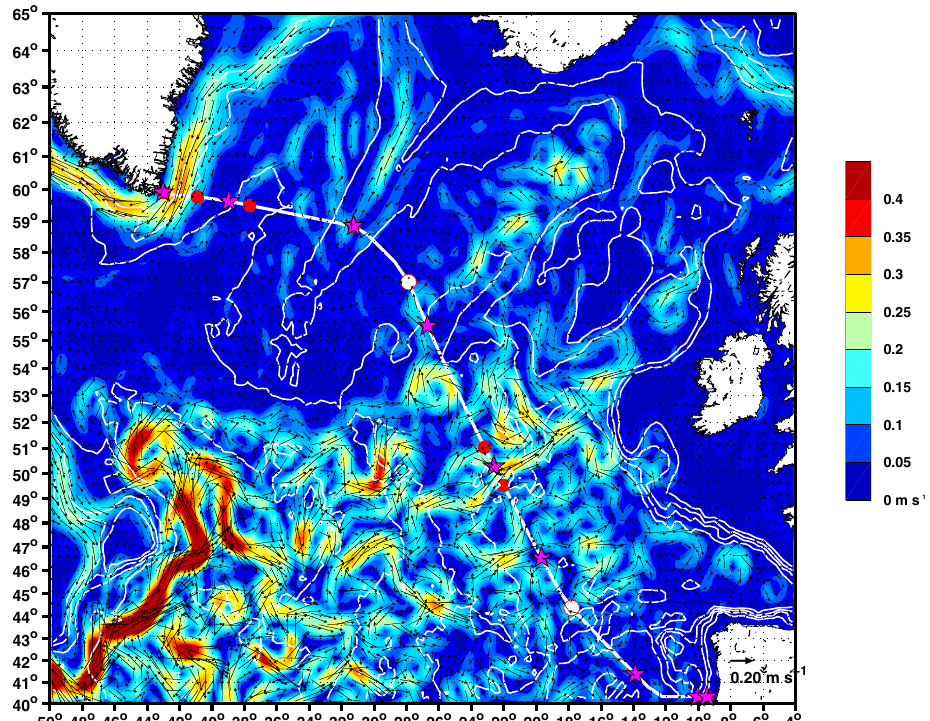
Figure 5. Surface velocities (ms − 1 ) derived from AVISO data: arrows indicate current direction and colors indicate current intensity. The white line represents the OVIDE section. The red and white points indicate the extension of the different dynamical structures crossing the OVIDE section in 2014. The white points delimit the extension of the NAC. The pink stars indicate the position of the GEOVIDE super stations and XL stations. The bathymetry contours every 1000m are indicated by light white